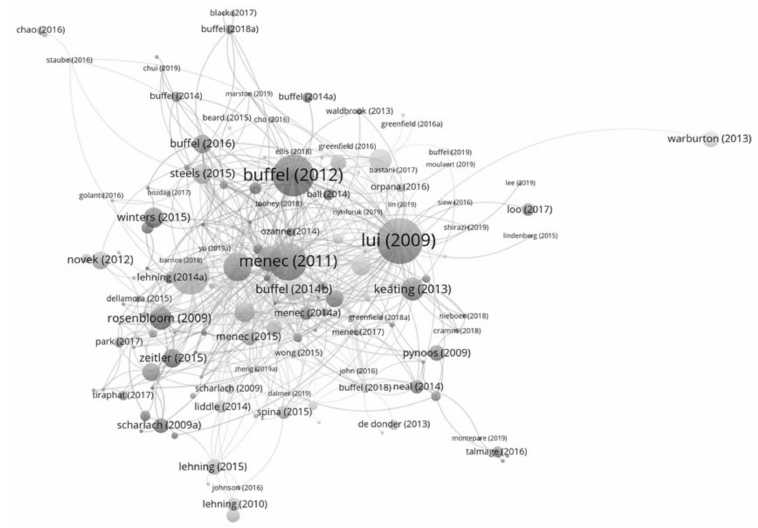
Figure 4. Citation analysis of age-friendly community